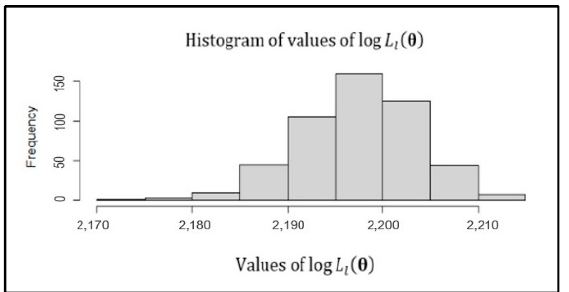
( θ ) , for 𝓀 = 500, m = 10, l = 9, n = 111. l